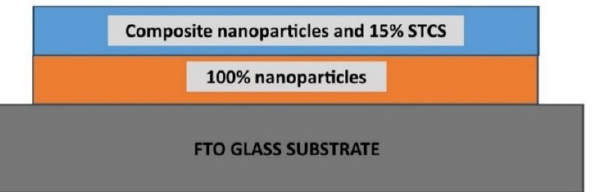
Figure 2. Illustration of the optimized configuration sample (synthesized sample). The bottom layer consists of the synthesized nanoparticles and the upper layer consists of the nanoparticles and 15% STCS composite.